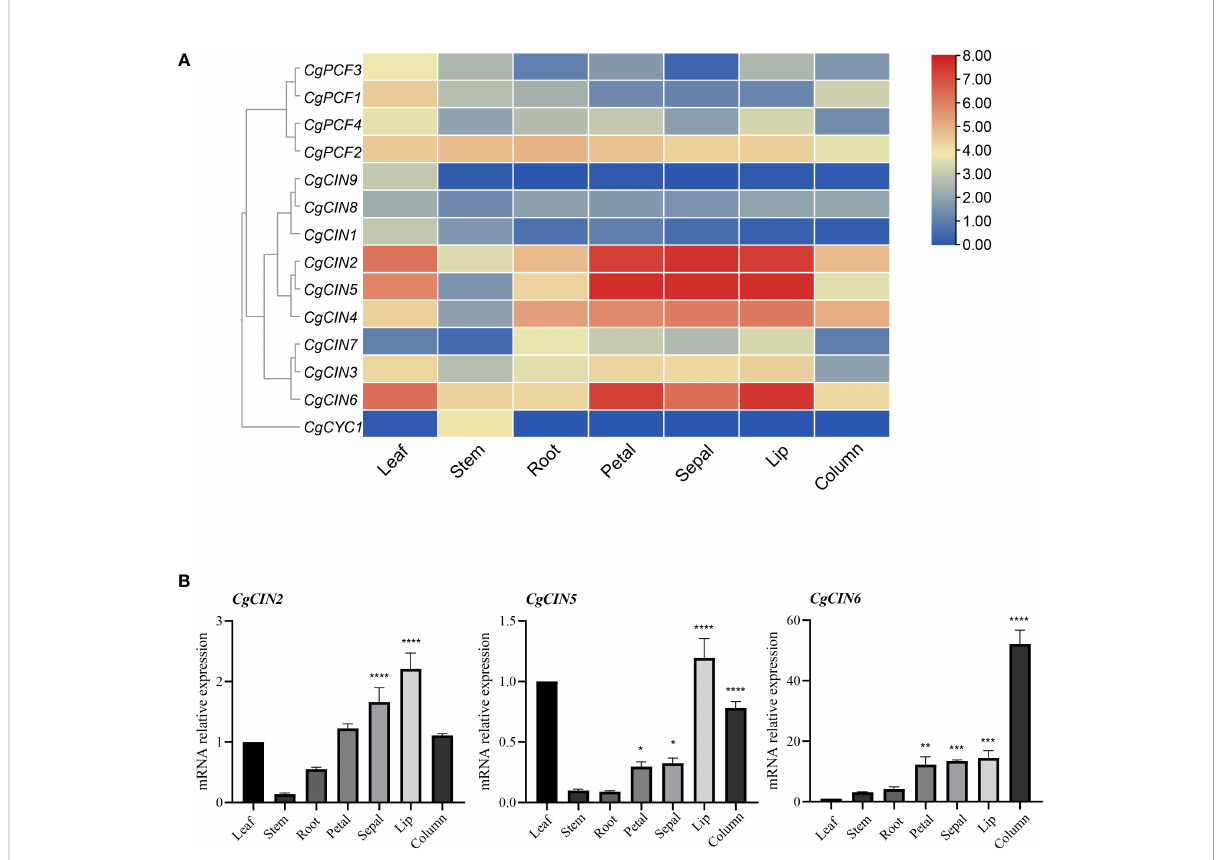
FIGURE 6 The expression pattern and RT − qPCR veri fi cation of TCP genes in seven tissues in C. goeringii . (A) Expression heatmap of TCP genes in seven tissues in C. goeringii. (B) Expression pattern of CgCIN2 , CgCIN5 and CgCIN6 in seven tissues in C. goeringii by RT − qPCR. We performed the ANOVA multiple comparisons in the statistical test, star marks *, **, ***, and **** representing adjusted p < 0.05, p < 0.01, p < 0.001, and p < 0.0001, respectively (Supplementary Table